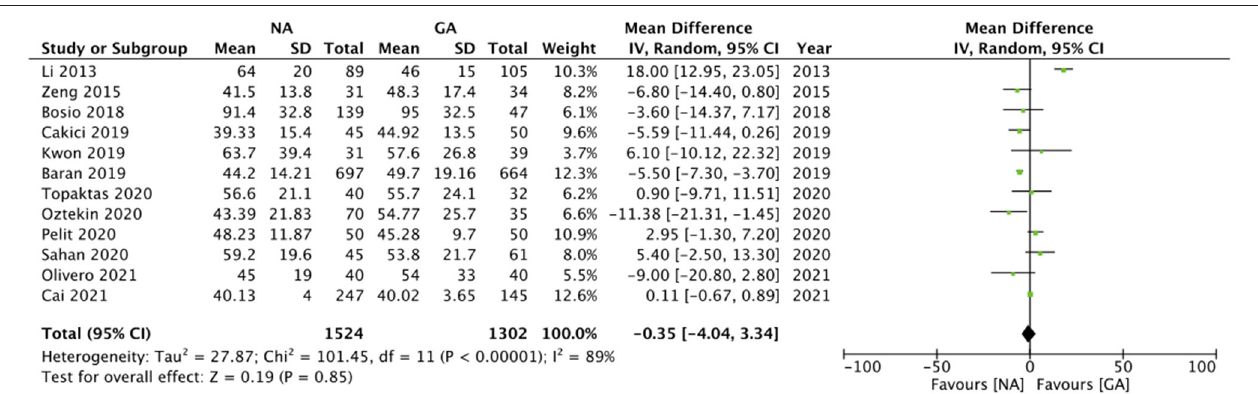
FIGURE 3 | Meta-analysis of operation time between NA and GA for RIRS.